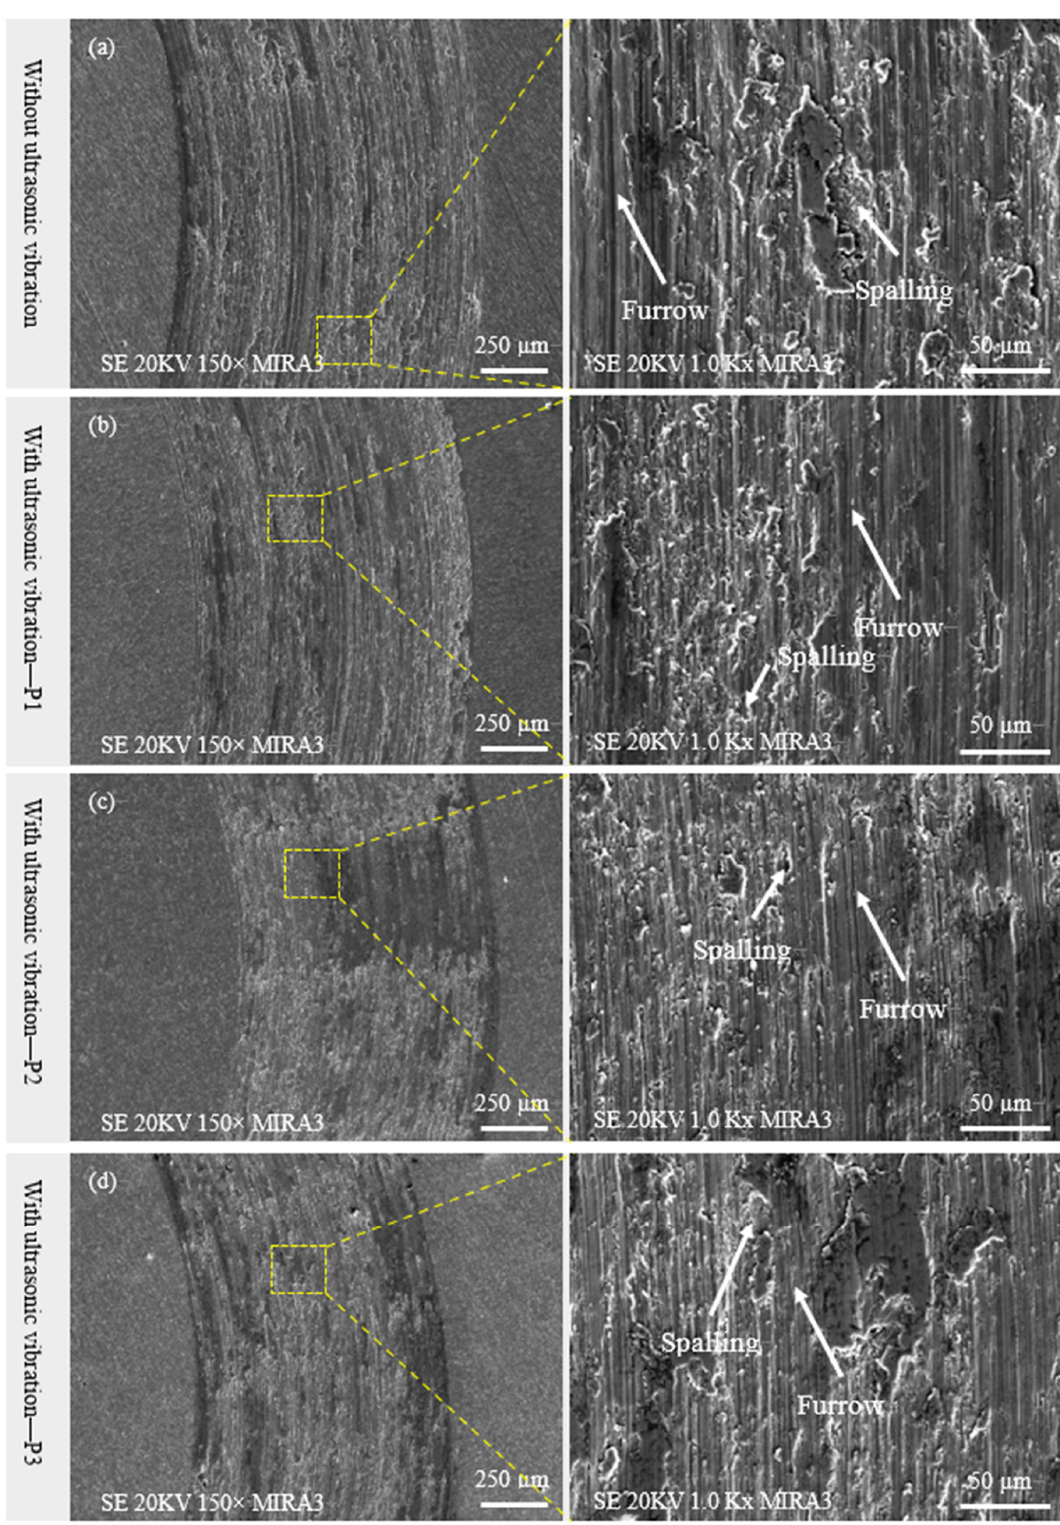
Figure 13. Wear morphology images of coatings prepared by laser cladding assisted with different ultrasonic vibration power: ( a ) P0-Coating, ( b ) P1-Coating, ( c ) P2-Coating, ( d )